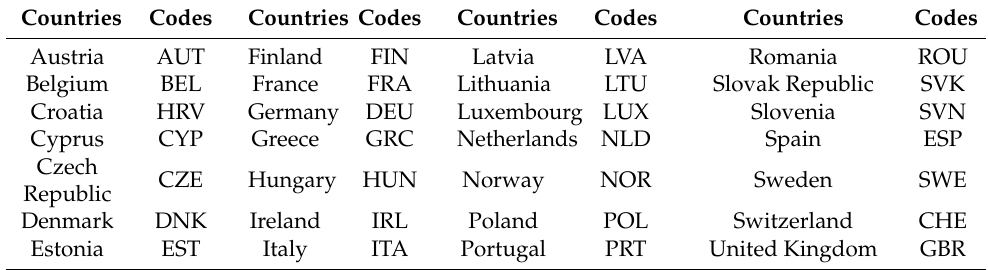
Table 2. The list of selected countries. Countries Codes Countries